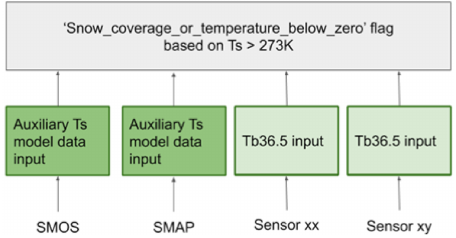
Figure 3. A schematic overview of the set up and dependencies of the ESA CCI SM’s “Snow _coverage_or_temperature_below_zero” flag.